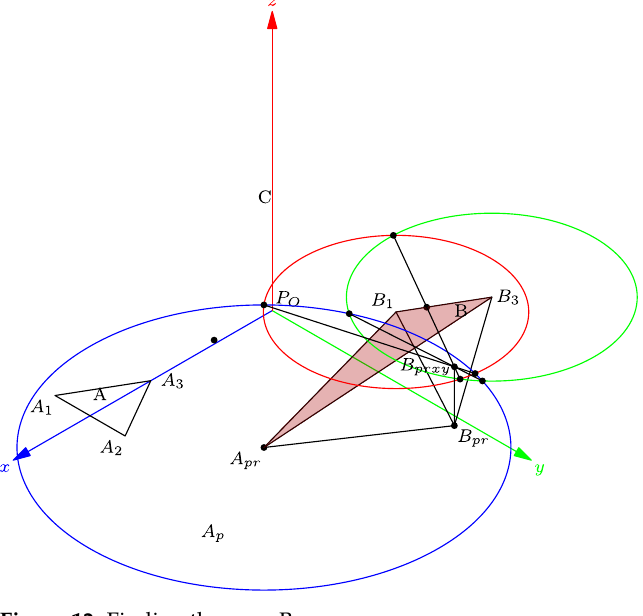
Figure 12. Finding the apex B pr